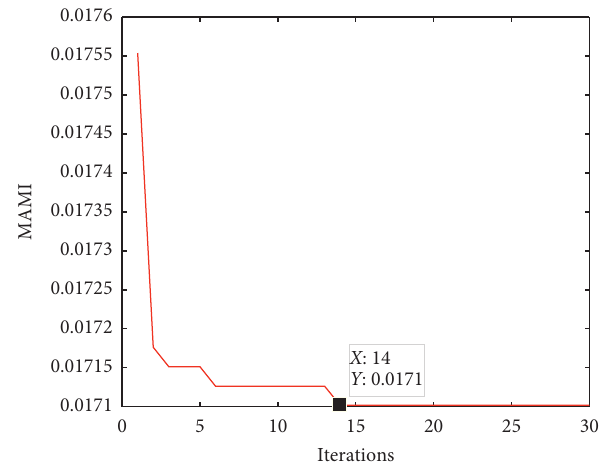
Figure 4: Convergence curve of